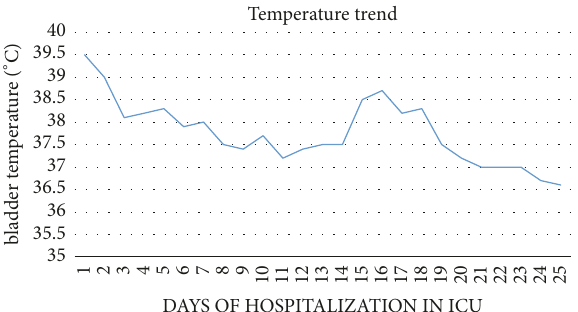
Figure 4: Temperature trend (the therapy with ceftolozane/tazobactam started on day